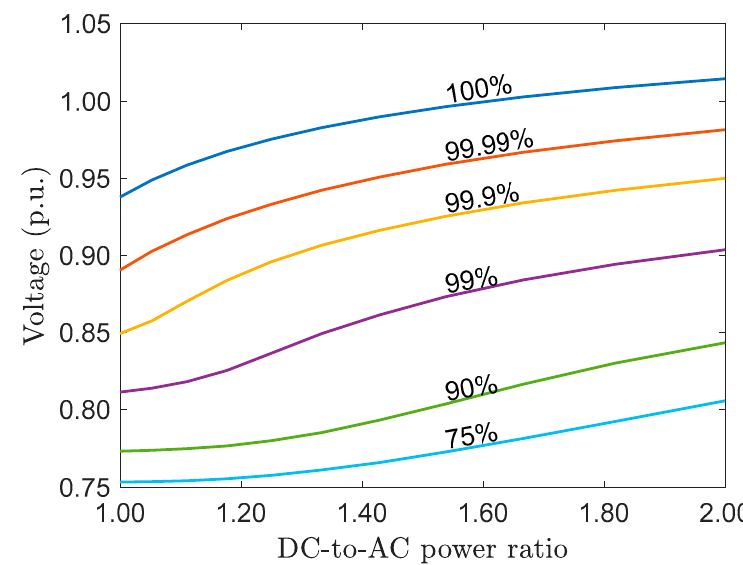
Figure 12. The probability density distributions of the operating voltage for DC-to-AC power ratios between 1.0 and 2.0 with a step of 0.1 during the observation period.